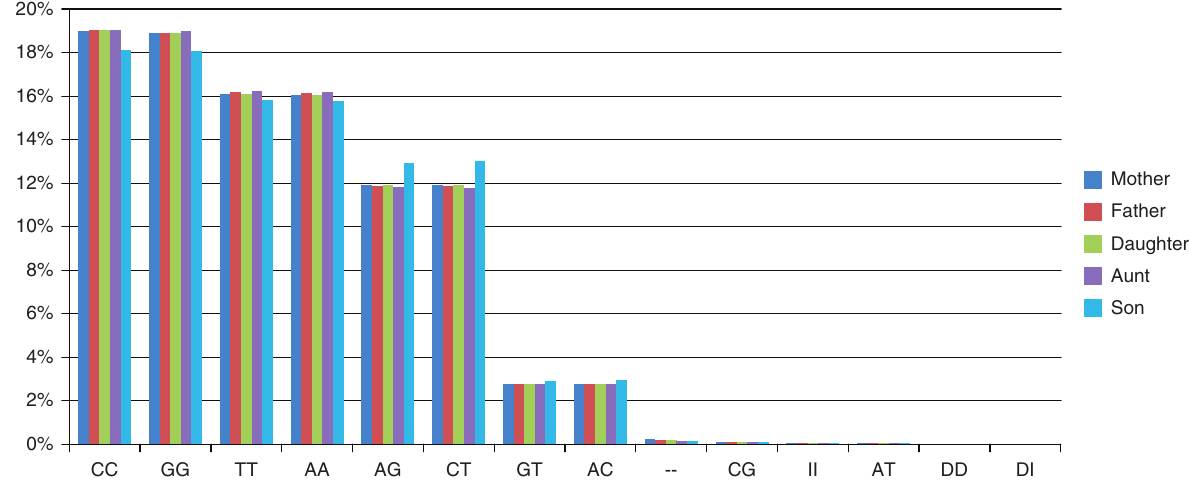
Figure 3. A distribution of all the different occurring genotypes as a percentage of the total for all individuals is shown. For the purposes of unbiased comparison, only autosome data is included. I and D indicate insertion and deletion, respectively. Son’s percentages (v2) show slight differences to all other v3 individuals whose genotype proportions are more similar.